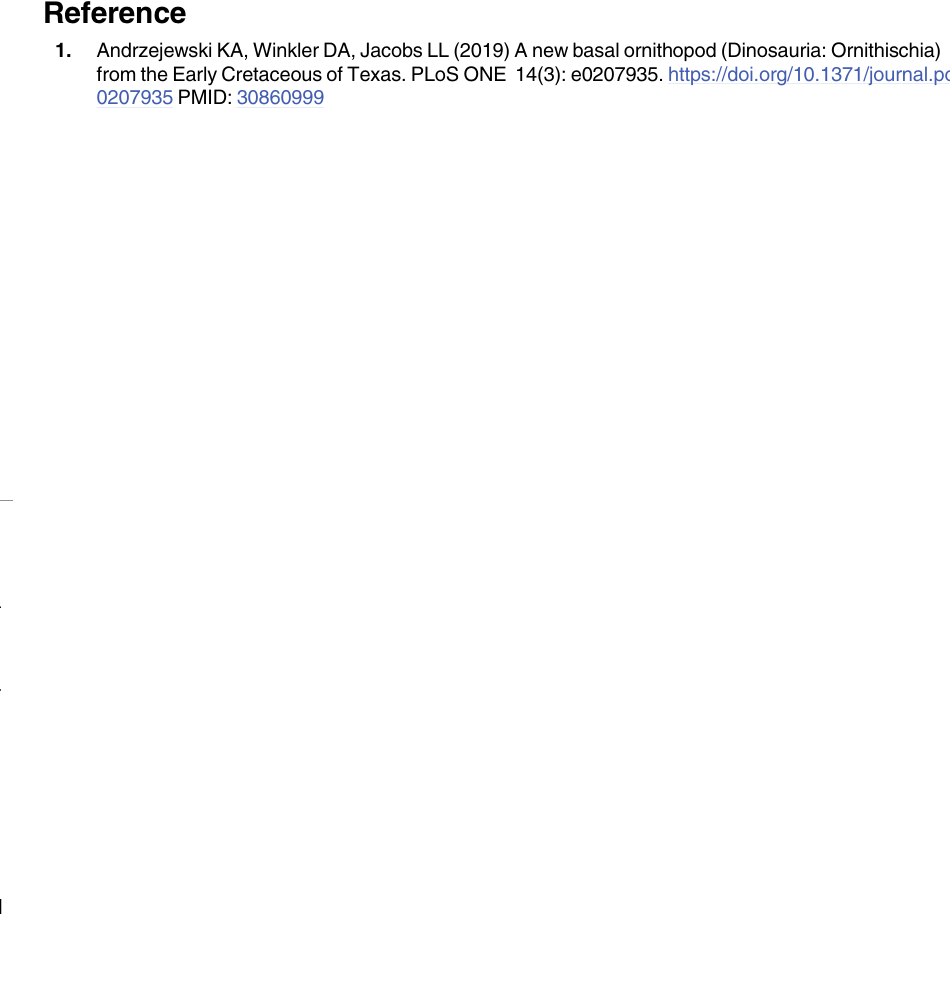
S3 Table. Scored character